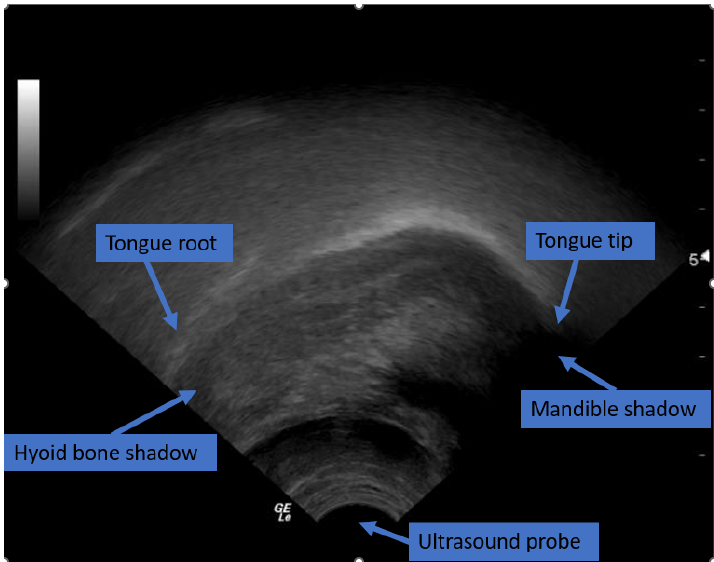
Figure 2. Ultrasound image of the tongue showing the tongue tip and root in the sagittal plane. The ultrasound probe on the bottom and the shadowing effect of the mandible and hyoid bone are visualized. The copyright for this ultrasound picture belongs to the author of this article, Khalid Al-hammuri